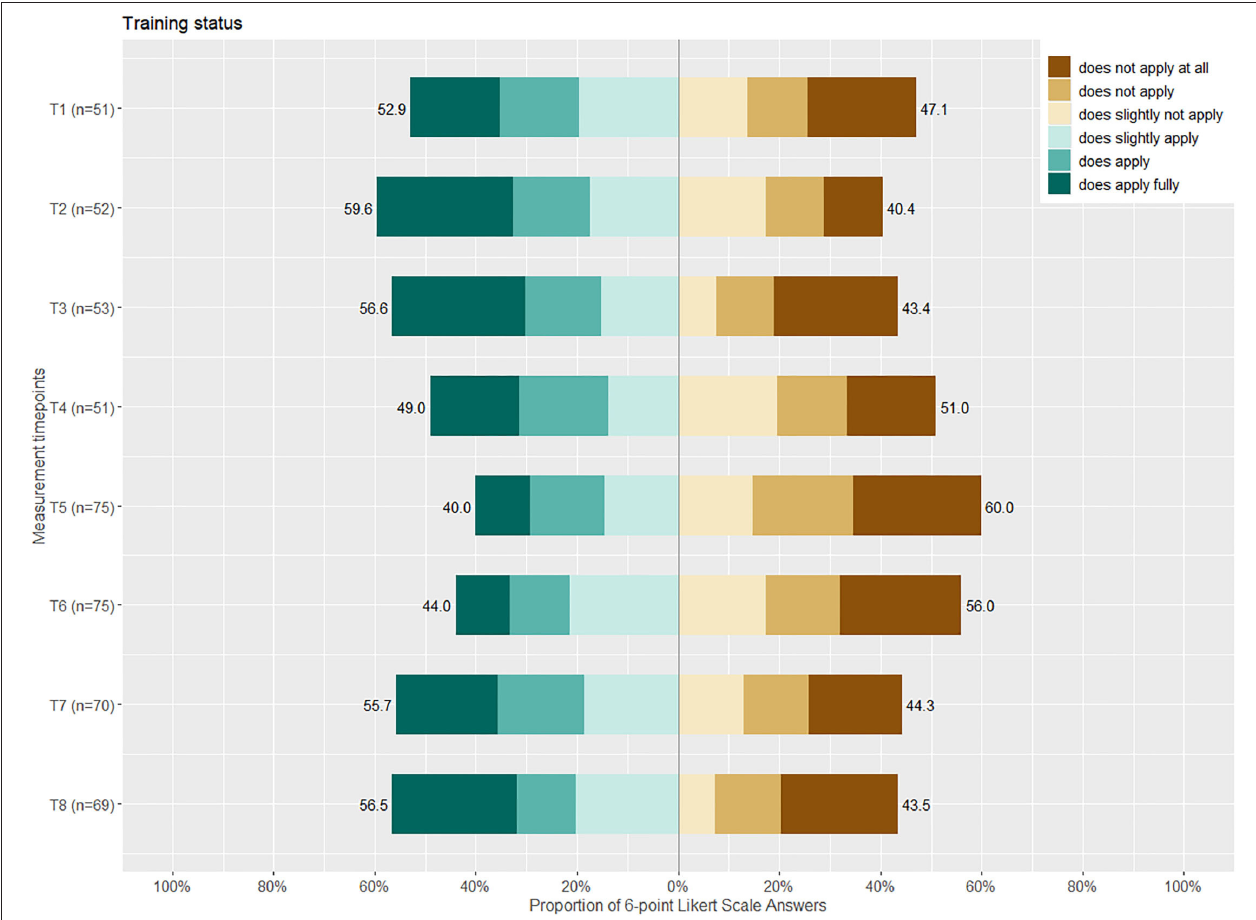
FIGURE 2 | A bar chart of the 6-point Likert scale, given the statement to have been less active since the beginning of the COVID-19 pandemic, with the answers ranging from does not apply at all to does apply fully with the according sum of percentages of positive or negative answers given per measurement timepoint (T1-8).